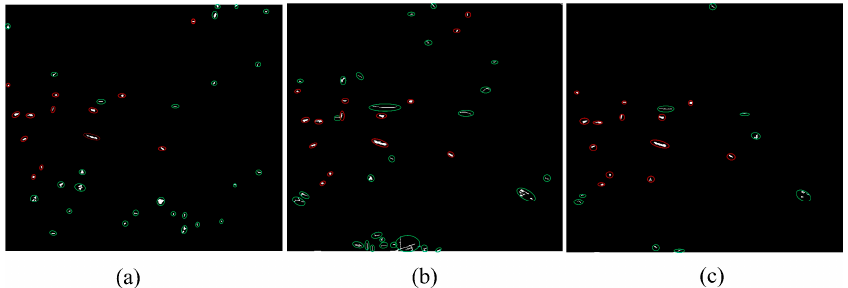
Figure 9. The detection results. 6 10 − = p ( a ) Two-parameter method. ( b ) Multiscale method. ( c ) fa Superpixel method. The red ellipses and green ellipses in the figures represent the correct and false test results respectively.